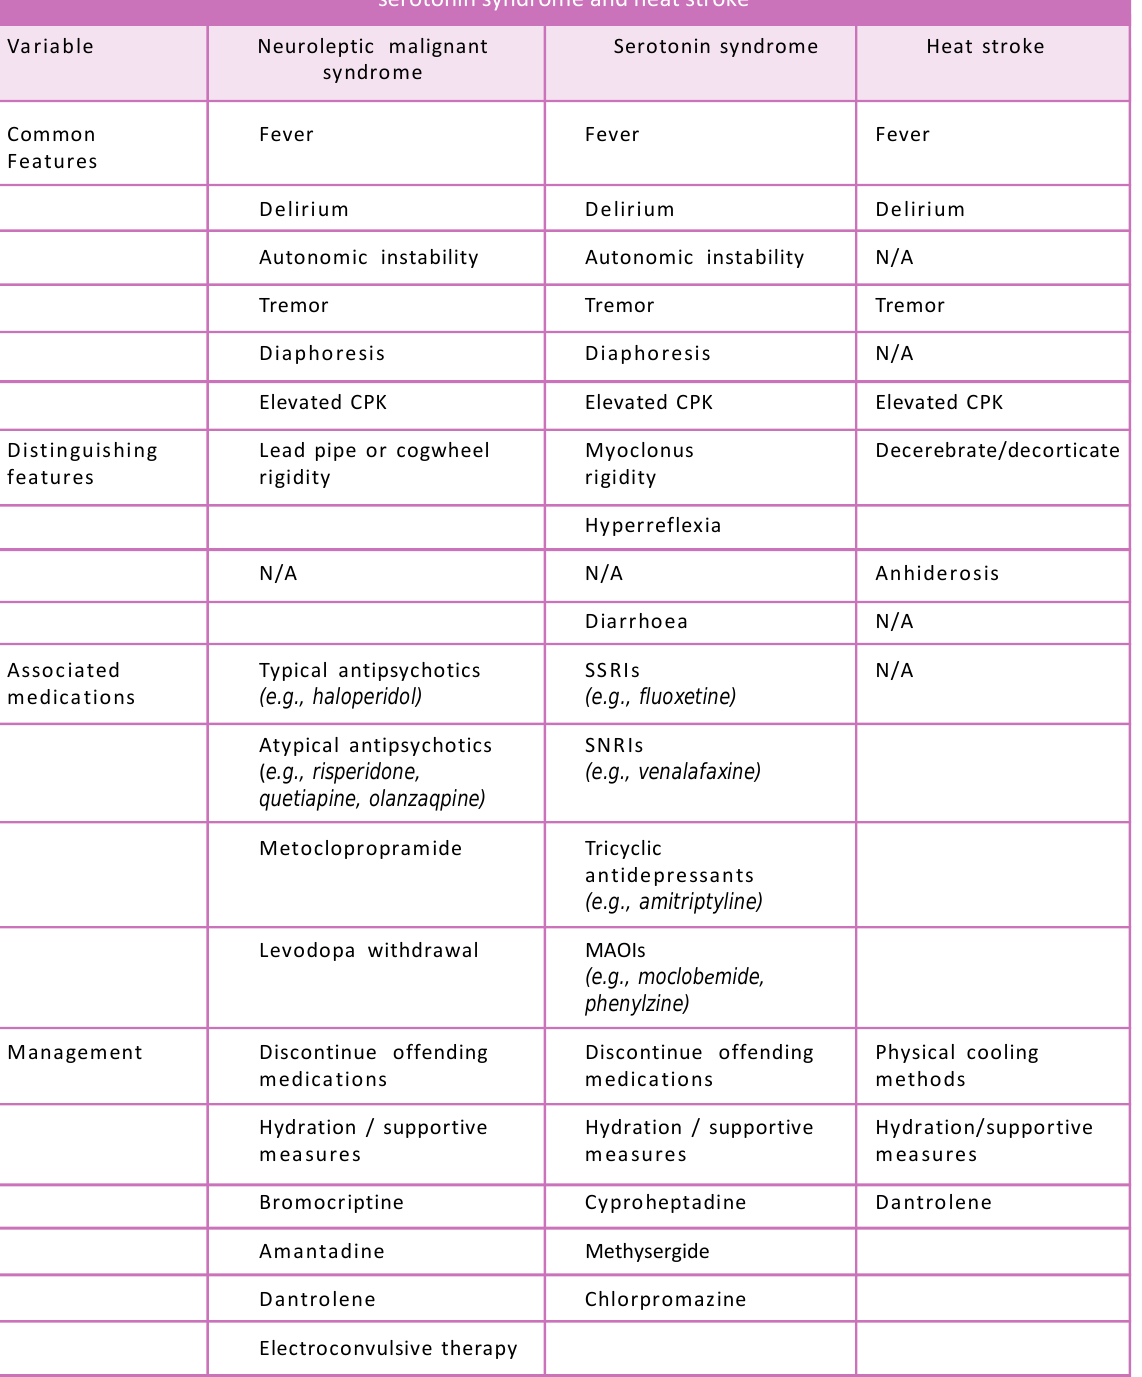
Table 1. Comparison of the principal characteristics of neuroleptic malignant